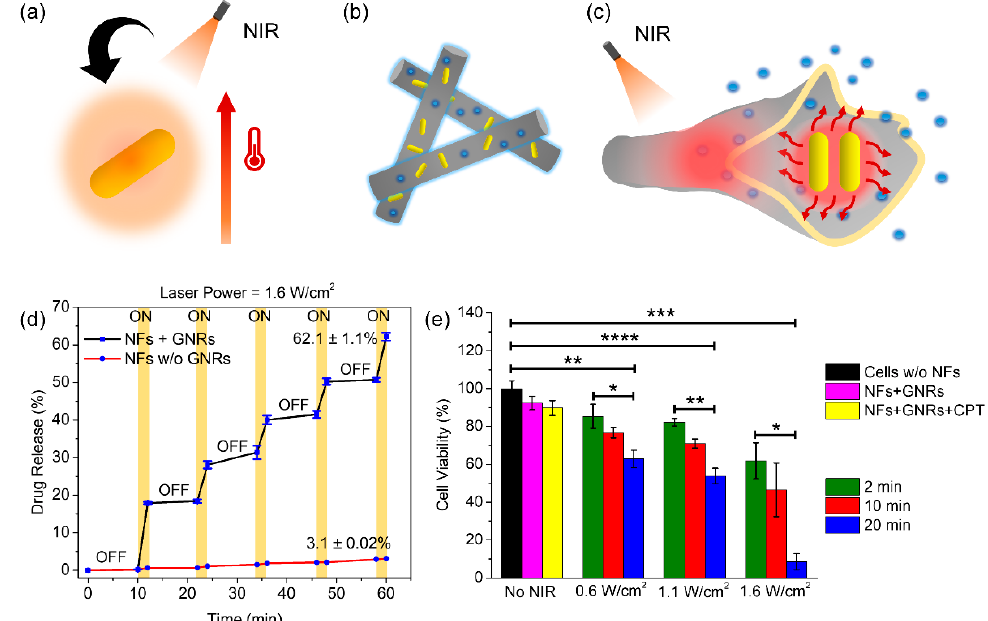
Figure 11. Schematic of ( a ) heat generated by GNRs upon NIR irradiation, ( b ) NFs encapsulating drug and GNRs after electrospinning, and ( c ) drug release due to shrinkage of NFs upon NIR irradiation. ( d ) Pulsatile drug release from NFs through the cyclic on–off of NIR light irradiation at different time intervals. ( e ) Cell viability of U87 cells due to CPT release from the NFs upon NIR irradiation at different time intervals. Reproduced with permission from [80], CC BY license, Copyright © 2021 The Authors, Published by MDPI. * p ≤ 0.05, ** p ≤ 0.01, *** p ≤ 0.001, **** p ≤ 0.0001.